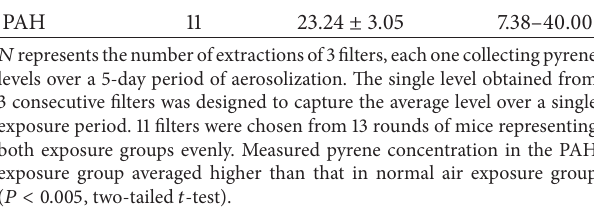
Table 2: Pyrene concentrations (ng/m 3 ) in exposure chamber. Exposure 𝑁 Mean + SE Range Normal air 11